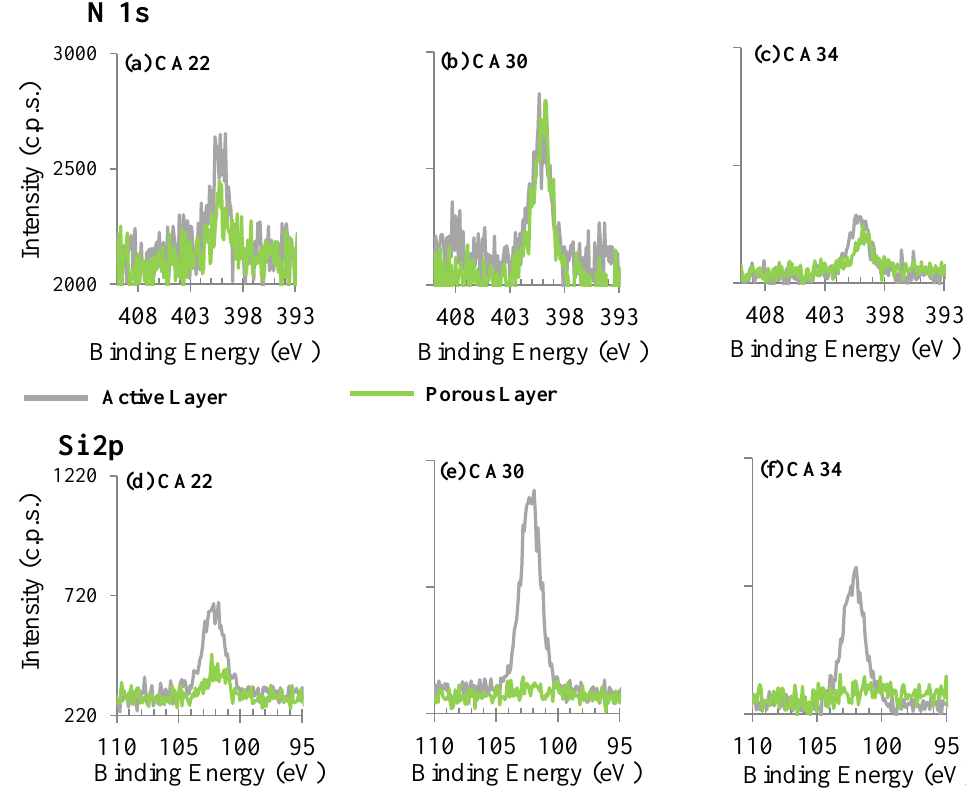
Figure 7. XPS N 1s and Si 2p regions of active layers (AL, grey spectra) and porous layers (PL, green spectra) of CA membranes (without Ag). ( a ) CA22, ( b ) CA30, and ( c ) CA34.